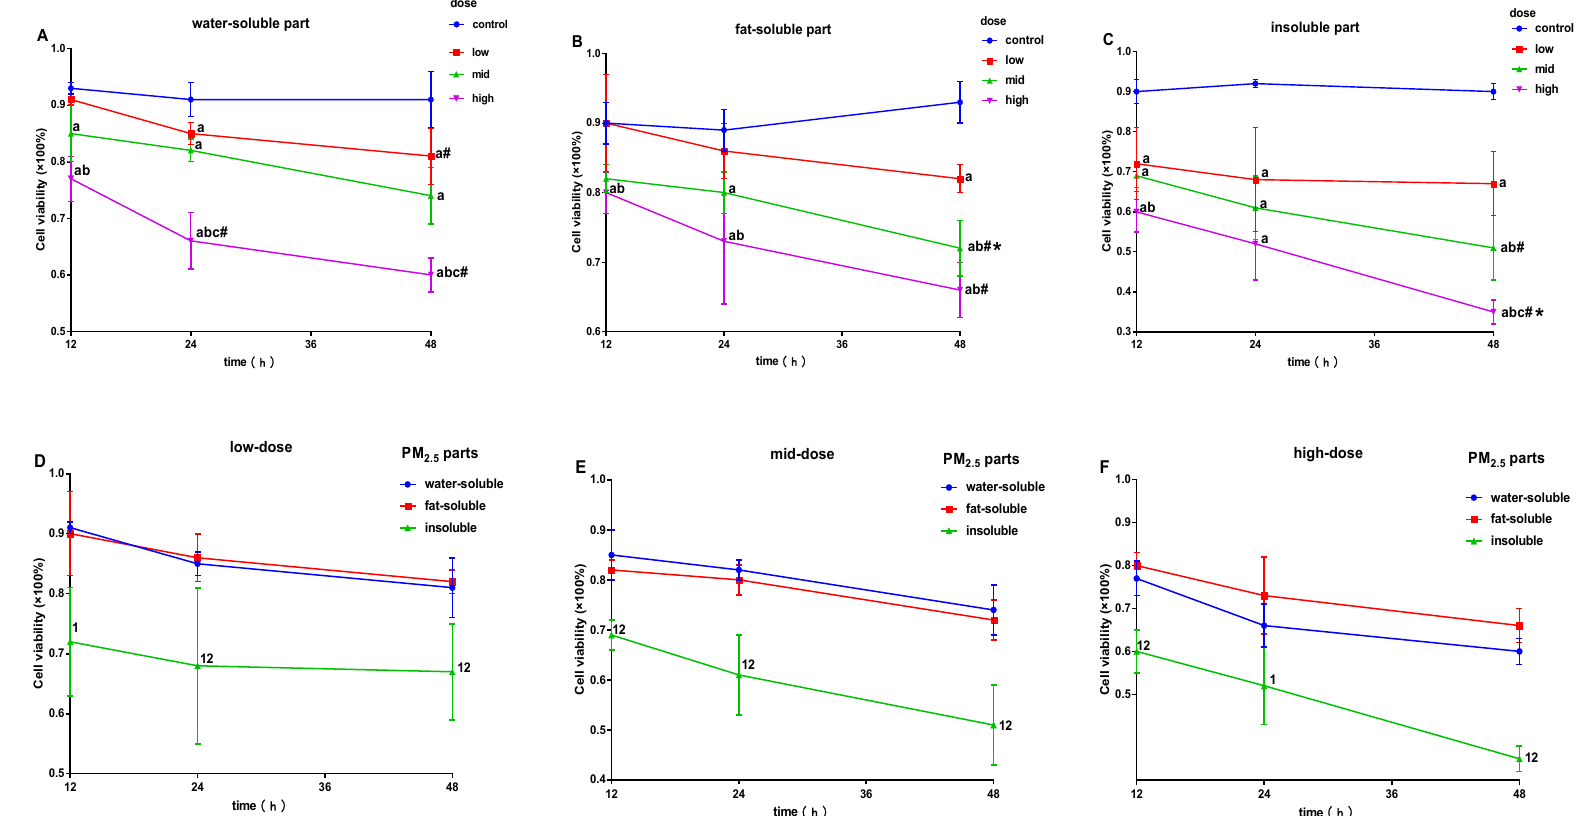
Figure 2. Effects of PM 2.5 on the cell survival rate of macrophages. ( A ) Effects of W-PM 2.5 on cell survival rates; ( B ) effects of F-PM 2.5 on cell survival rates; ( C ) effects of I-PM 2.5 on cell survival rates; ( D ) effects of low-dose PM 2.5 on cell survival rates; ( E ) effects of mid-dose PM 2.5 on cell survival rates; ( F ) effects of high-dose PM 2.5 on cell survival rates. Data are presented as means ± SD of three independent experiments. a p < 0.05 vs. control group at the same time; b p < 0.05 vs. low-dose group at the same time; c p < 0.05 vs. mid-dose group at the same time; # p < 0.05 vs. 12 h group at the same dose; * p < 0.05 vs. 24 h group at the same dose; 1 p < 0.05 vs. W-PM 2.5 at the same dose; 2 p < 0.05 vs. F-PM 2.5 at the same dose .